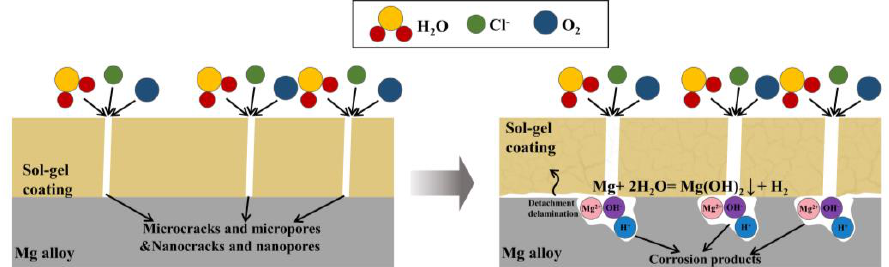
Figure 3. The schematic diagram of the anti-corrosion principle of bare sol-gel